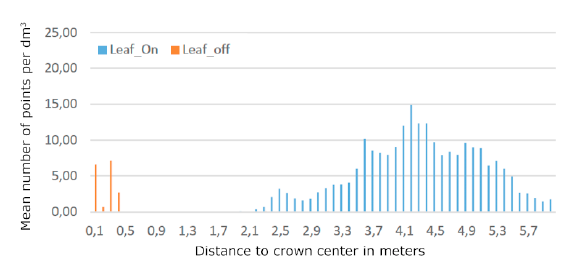
Figure 6. Mean point density per 5x1 dm 3 in various distances to the crown centre in level 1 - 1,5 m